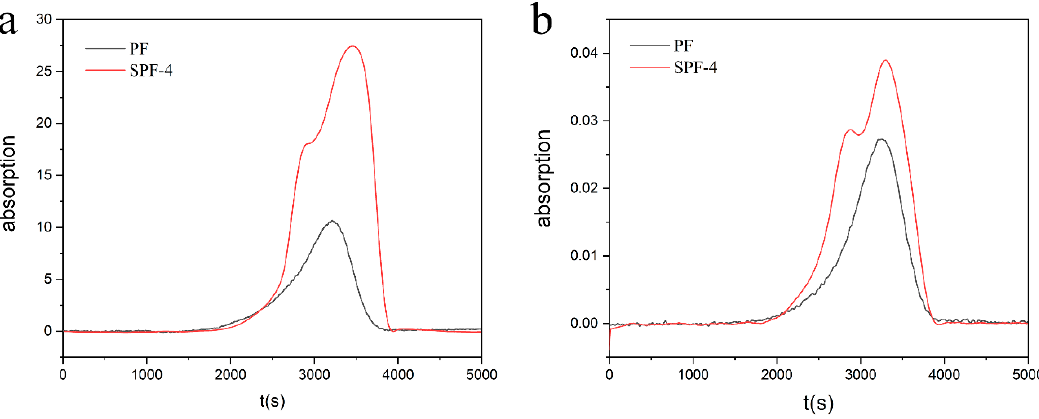
Figure 16. The intensity of the characteristic peak ( a ) CO 2 and ( b ) CO in TG-IR spectra in air.